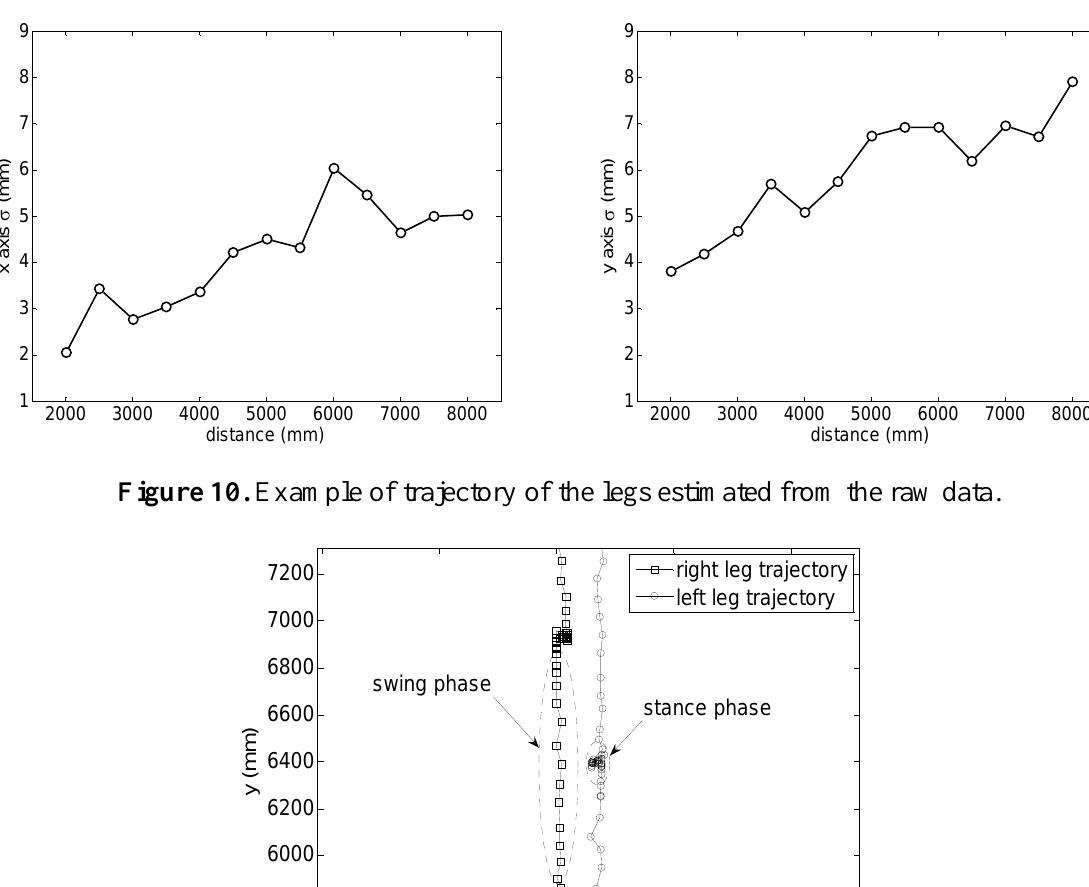
Figure 9. Evolution of the standard deviation of the estimated position of the centre of the legs relative to the distance.